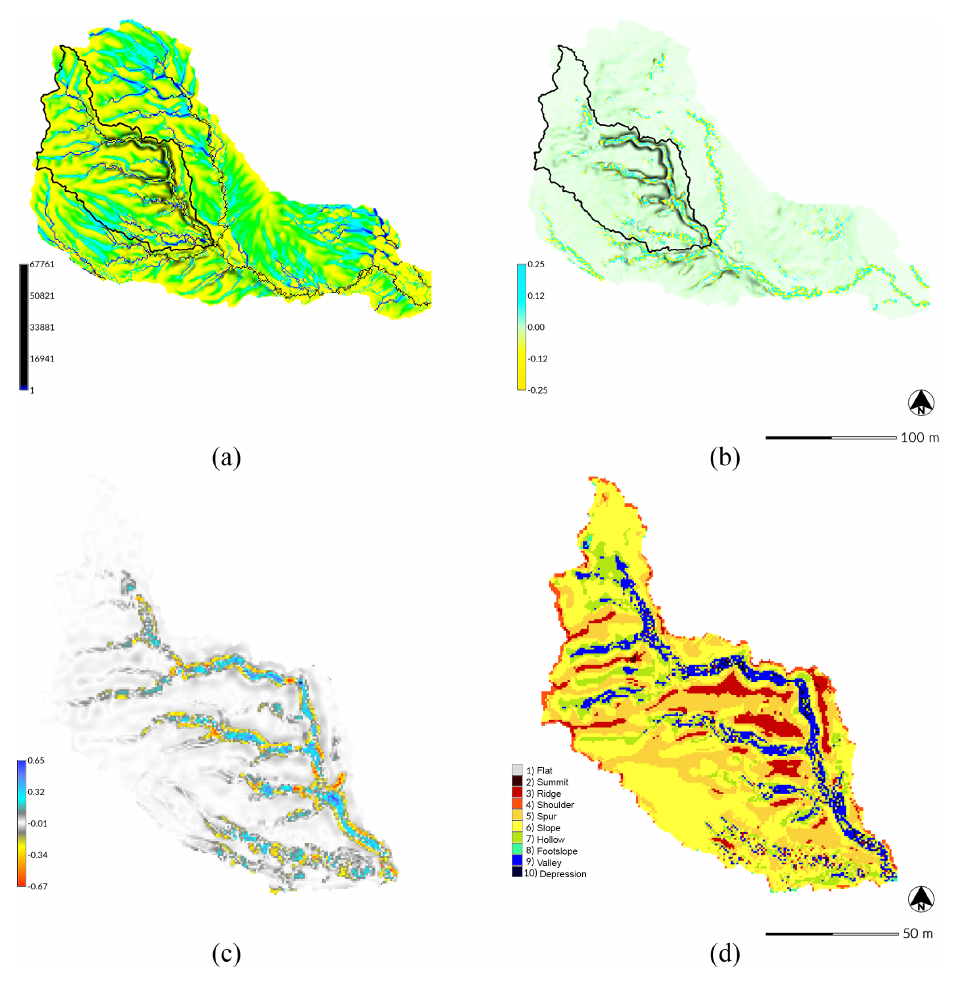
Figure 8. Dynamic simulation with USPED for a 120min event with a rainfall intensity of 50mmh − 1 for Patterson Branch, Fort Bragg, NC: (a) flow accumulation and (b) erosion–deposition [kgm − 2 s − 1 ] for the subwatershed in the final 3min time step; (c) net difference [m] and (d) landforms for drainage area